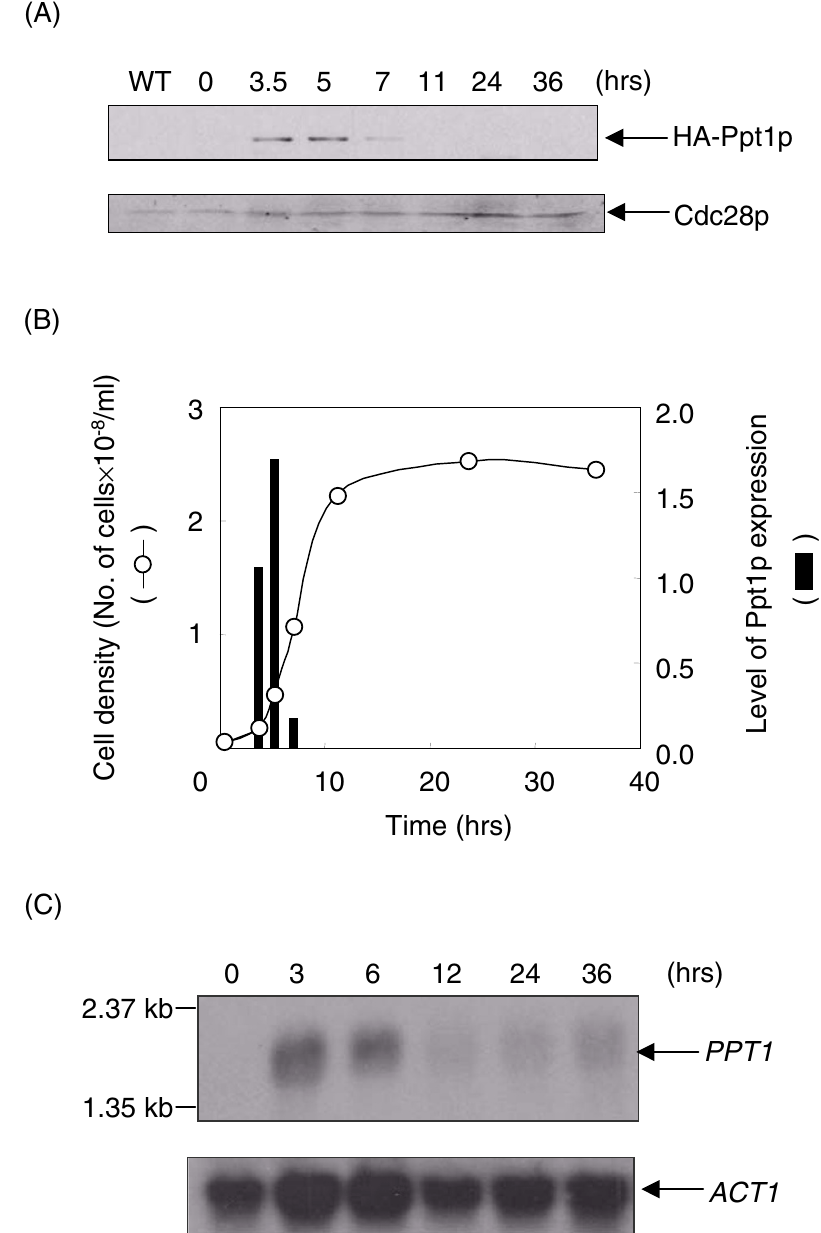
Expression of HA-Ppt1p as a function of cell growth . (A) An overnight culture of WHT4-1 cells (OD 600 nm 5~10) was used to inoculate fresh medium to OD 600 nm 0.2 and the culture grown at 30°C. At the indicated times samples were prepared and subjected to immunoblotting using anti-HA antibody. The lower panel shows the bottom half of the same blot probed with anti-Cdc28p antibody. This experiment was performed four times independently with similar results. WT; wild type. (B) The growth curve was plotted based on direct cell counting using a hemocytometer. The relative amount of HA-Ppt1p was obtained by taking the ratio of the band intensity of HA-Ppt1p to Cdc28p. (C) Total RNA was isolated at the indicated time after the inoculation of an overnight culture of W303 cells (OD 600 nm 5~10) to OD 600 nm 0.2. Twenty micrograms of RNA per sample were resolved and subjected to Northern analysis with a 32 P-labeled PPT1 cDNA probe. The lower panel shows the same blot probed for yeast actin mRNA. This experiment was repeated four independent times for both W303 and WHT4-1 cells with similar